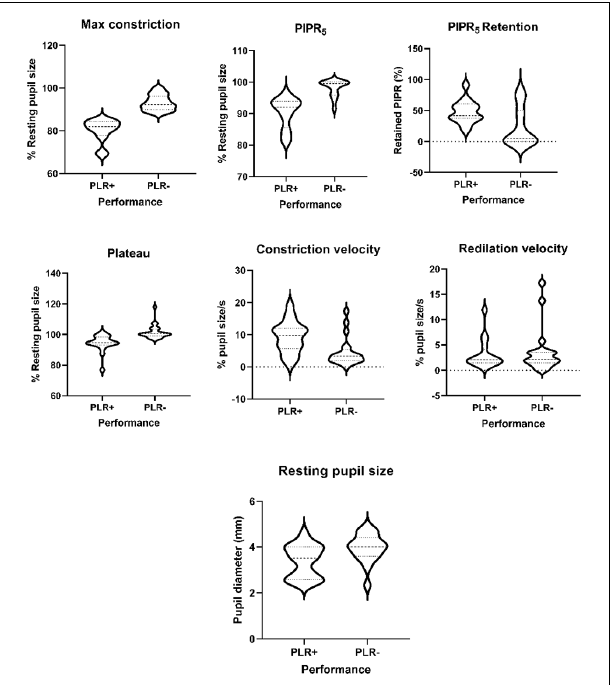
FIGURE 2 | Violin plots of the pupillary light reflex (PLR) parameters in good performers (PLR+) abd poor performers (PLR − )